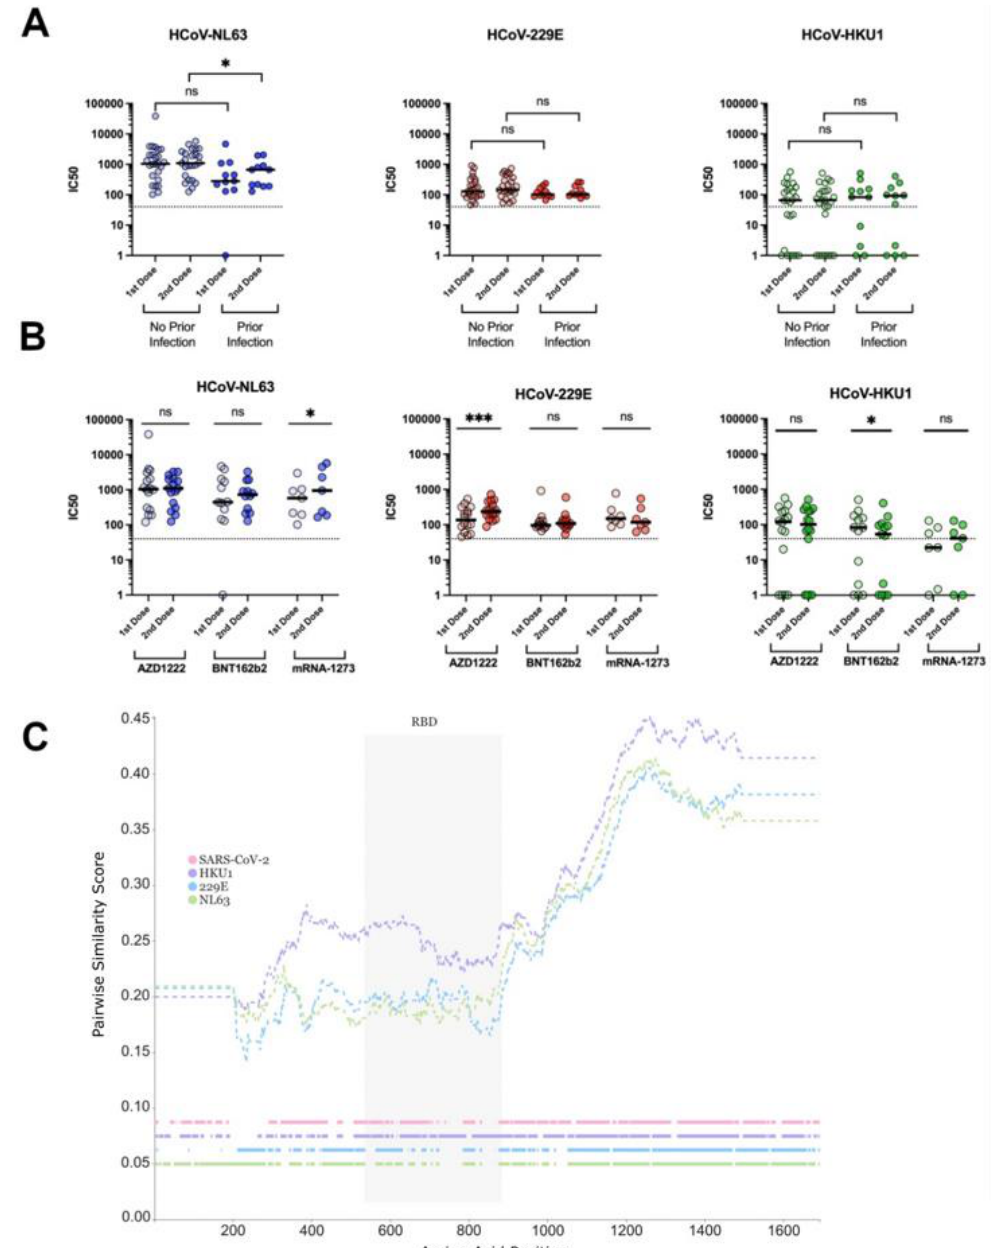
Figure 4. Comparing neutralising responses in HCoVs NL63, 229E, and HKU1 between first- and second-dose vaccination against SARS-CoV-2. Neutralization profile against HCoVs NL63, 229E, and HKU1 in double-dosed BNT162b2, mRNA-1273 or AZD1222 –vaccinated subjects with or without a history of SARS-CoV-2 infection. ( A ). Neutralizing antibody titres against the aforementioned HCoVs after the first and second dose administration of BNT162b2, mRNA-1273 or AZD1222 vaccines. ( B ). Wilcoxon matched-pairs signed rank tests statistical analysis was used in A and B. Similarity plots ( C ) show HKU-1 spike as having more similar amino acid sequence to SARS-CoV-2 compared with both NL63 and 229E in all regions of the spike protein. Dashed lines on the top show amino acid pairwise similarity between SARS-CoV-2 and the 3 HCoV Spike proteins, plotted using a 400 amino acid window size and a step of 1. Positions with gaps were excluded from the windows. Horizontal lines on the bottom indicate residue presence for each of the 4 aligned coronaviruses across the alignment length (colour presence = amino acid presence; colour absence = gap). ns = not significant, * p < 0.05, *** p <